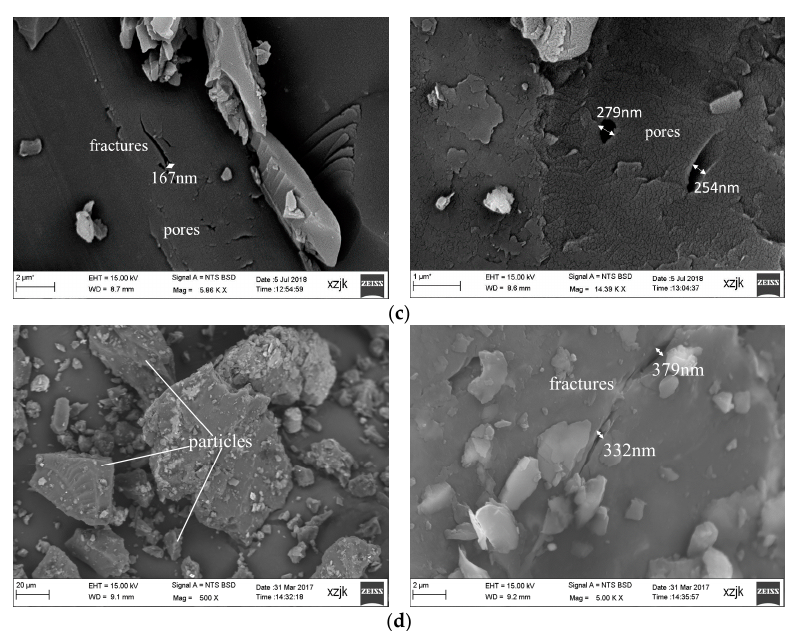
Figure 3. ( a ) On-site sampling photographs and ( b – d ) surface micromorphology of 5–15 mm, 2–5 mm, 0–2 mm coal particles from the 8 1 coal seam.